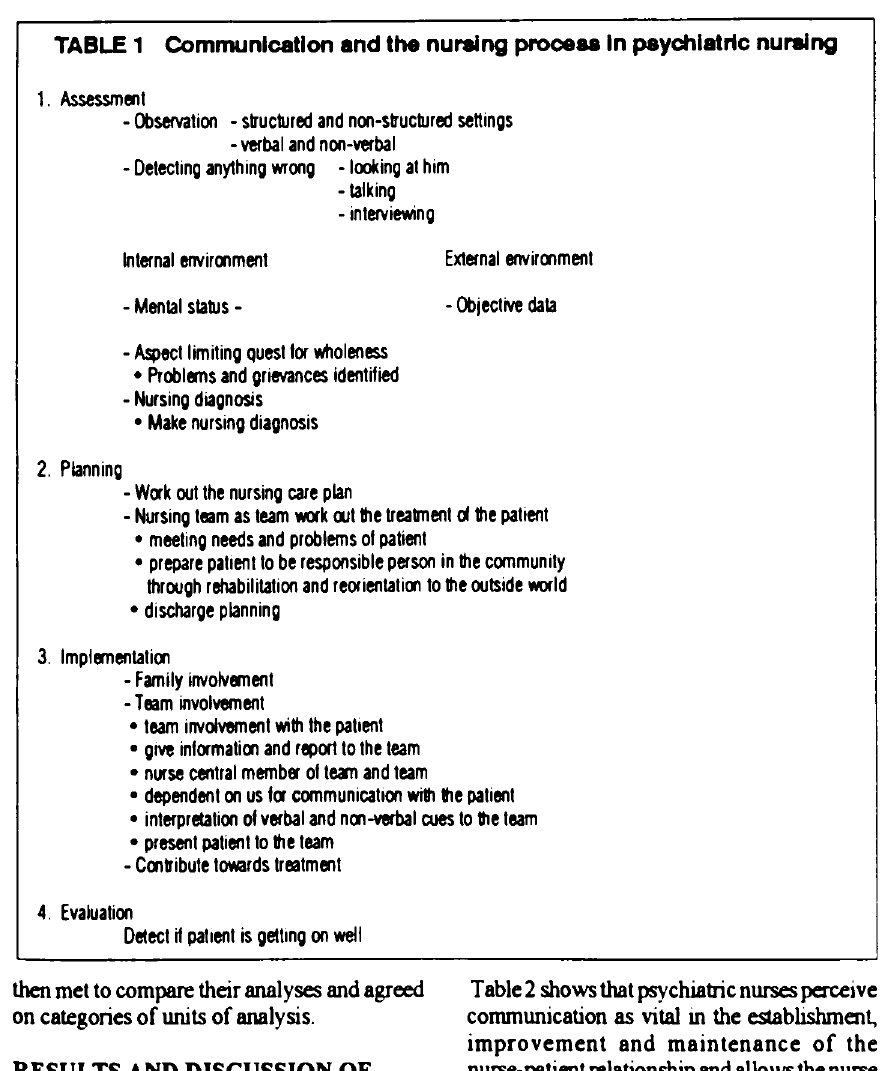
TABLE 3 Conrwnunication in interatlon